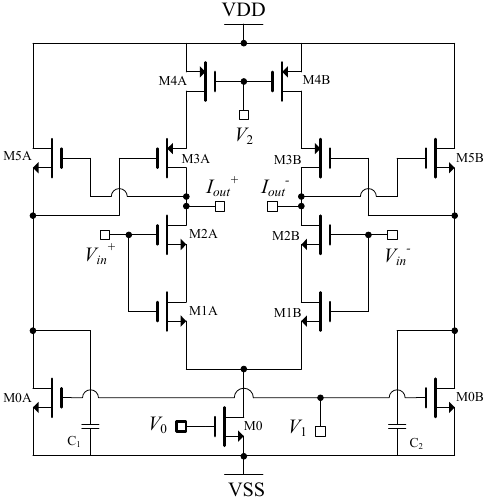
Figure 6. Open loop wideband current driver [12].